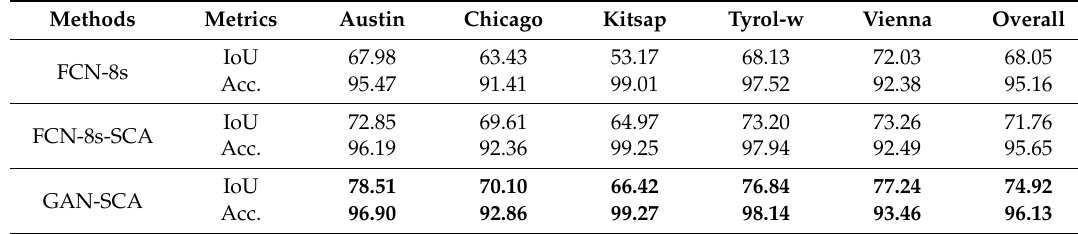
Table 4. Experimental results on Inria aerial image labeling